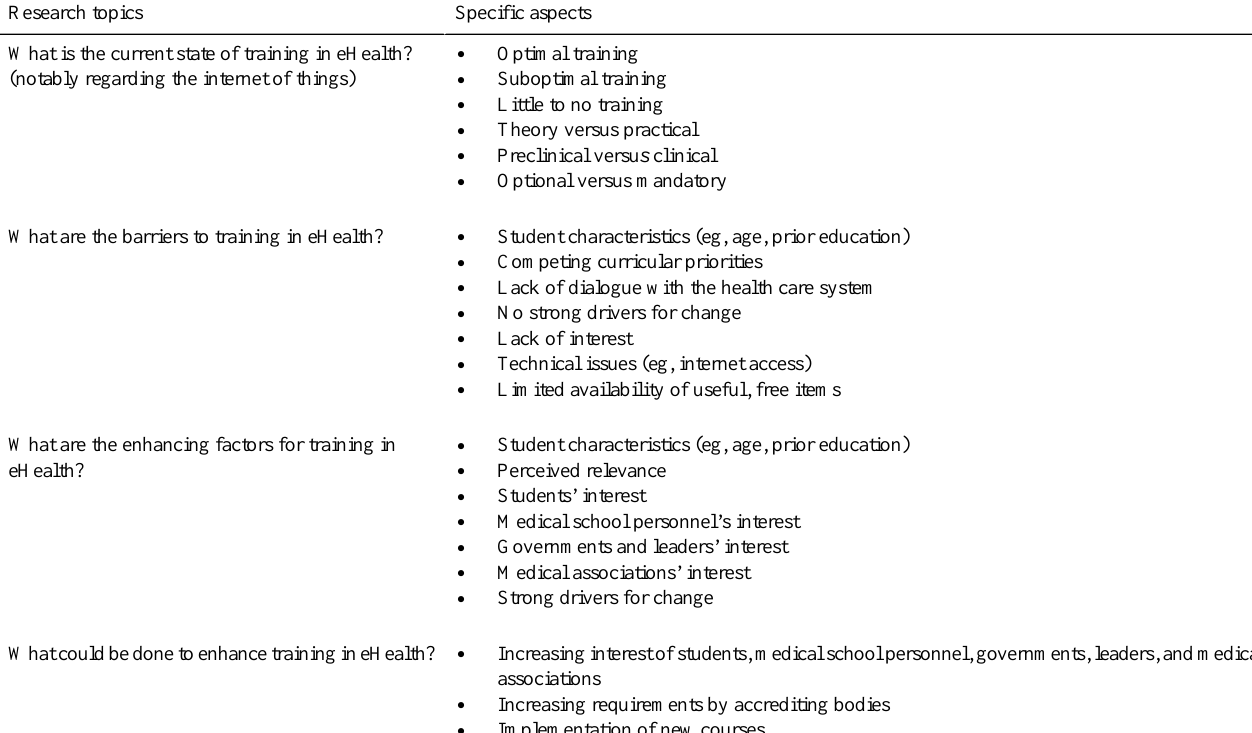
Table 4. Recommendations in the form of research topics and specific